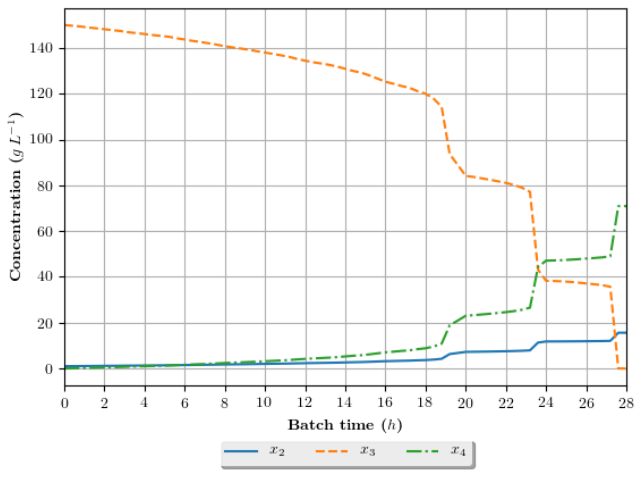
Figure 9. Growth profile for the assay of number 8 (4h/GA/cos—4h interval between DRTO cycles, GA as the optimization algorithm and cosinoidal feed rate parametrization), in terms of the concentration of cellular biomass ( x 2 ), substrate ( x 3 ) and ethanol ( x 4 ) during the